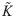
The normalized and centered K-function (K˜) increases as the Aggregate-to-Diffuse ratio (ADR) increases.Each K˜ result displayed represents the average of 30 simulated fields of view using the exact same experimental parameters. The x-axis in the right panels shows the radius at which K˜ was calculated (rk). Panel A: Left—ADR was varied (the proportion of particles allocated to aggregates) by varying the number of aggregates (Nagg) while keeping the Signal-to-Background ratio (SBR) constant. Note that the signal is added to the background. Since the aggregates have a pre-defined radius, SBR was not the exact same, but varied subtly due to “quantization” effects as the number of aggregates is increased. Right—As ADR increases, K˜ increases. This remains true at SNR = 2. Panel B: Left—ADR was varied by varying the SBR while keeping Nagg constant. Right—As ADR increases, K˜ increases. This remains true at SNR = 2.